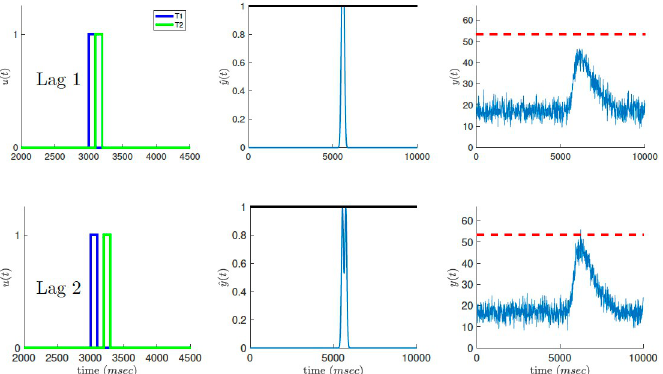
Fig 3. Lag-1 sparing effect. When T2 appears immediately after T1 (lag-1, top), their overlap in the first processing stage is maximal, resulting in a stronger reduction of the sensory trace due to the clipping threshold (solid black line). This causes a decrease in the attentional load at the second processing stage (bottom axis) with a corresponding reduction in blinking probability. At lag-2 (bottom), the overlap in the first stage is smaller, resulting in less clipping of the sensory trace and a higher attentional